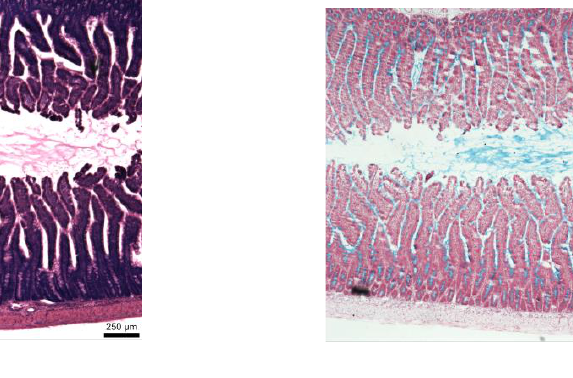
Figure 7. H&E and Alcian Blue and neutral red staining of mucosae 180 min after intra-jejunal instillations. Groups: PBS control, free SeMet (20 µ g/kg), SeMet NP (20 µ g/kg). Images captured using a light microscope. Goblet cells are indicated by ‘G’. Black arrows show epithelial sloughing. Horizontal bars on panels = 250 μm.